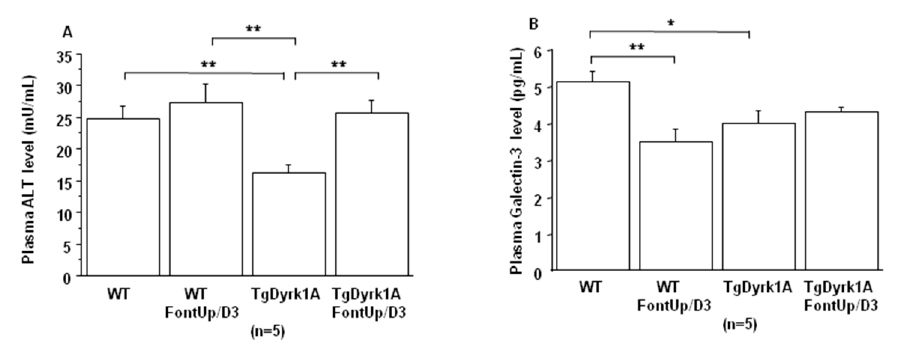
Figure 4. Comparison of plasma ALT ( A ) and Galectin-3 ( B ) levels obtained from WT and mice overexpressing Dyrk1A (TgDyrk1A) after oral gavage of D3 FontUp ® during eight days (FontUp / D3). The values are mean ± SEM of n (number of mice) mice. Statistical analysis was done as mentioned in data analysis. * p < 0.05, ** p < 0.005.